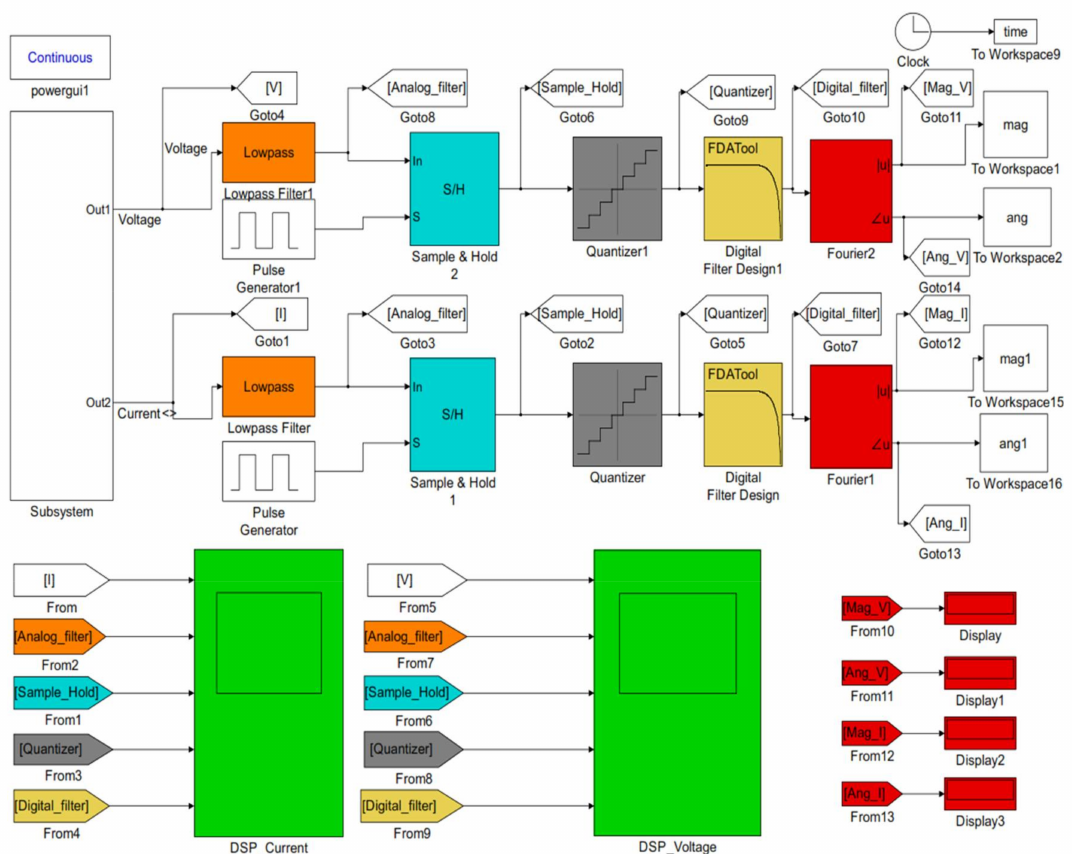
Figure 2. Model for current/voltage signal processing